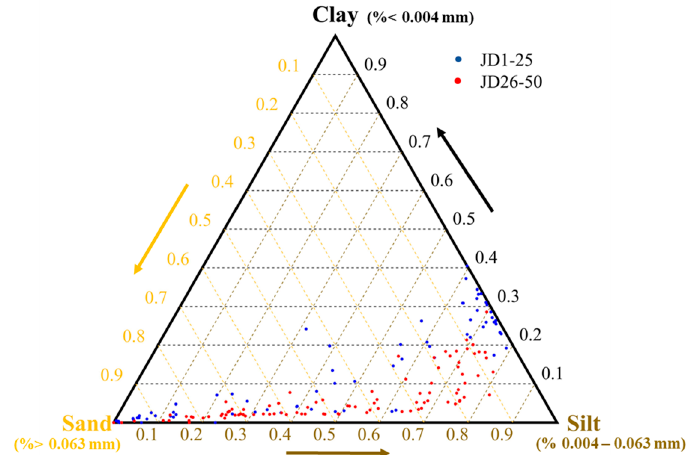
Figure 16. Sand-Silt-Clay triangle with two different color scatters, and colors representing differ- ent zones.